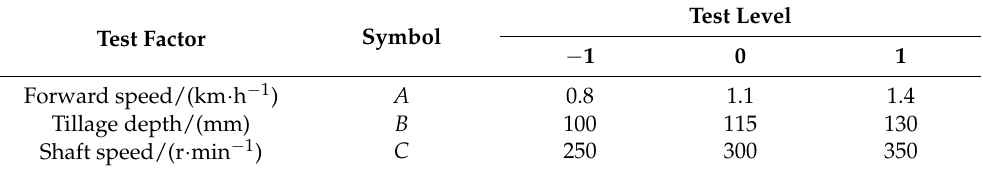
Table 5. Experimental factors